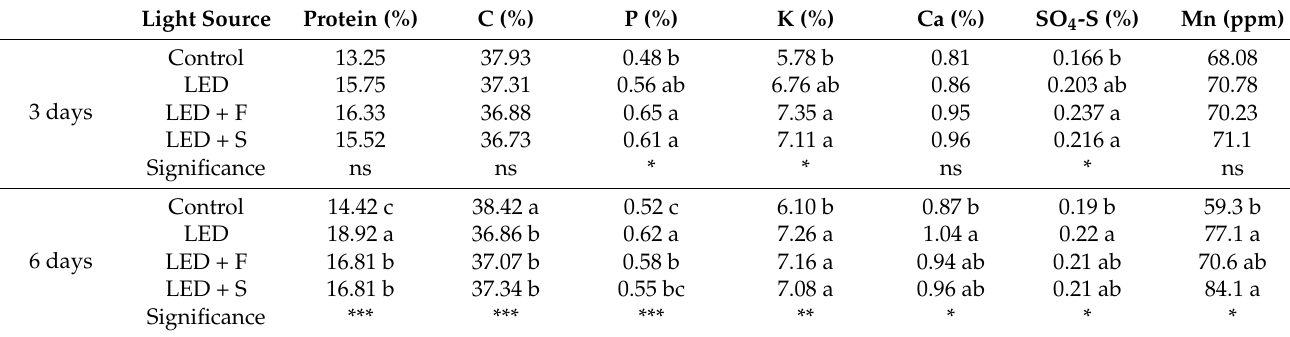
Table 3. Concentrations of essential nutrients in lettuce variety ‘New Red Fire’ subjected to supple- mental UV-A radiation. Treatments included LEDs, LEDs + focus lens (LED + F), LEDs + scatter lens (LED + S), and control (Con). Measurements were made after 3 and 6 days of treatments.